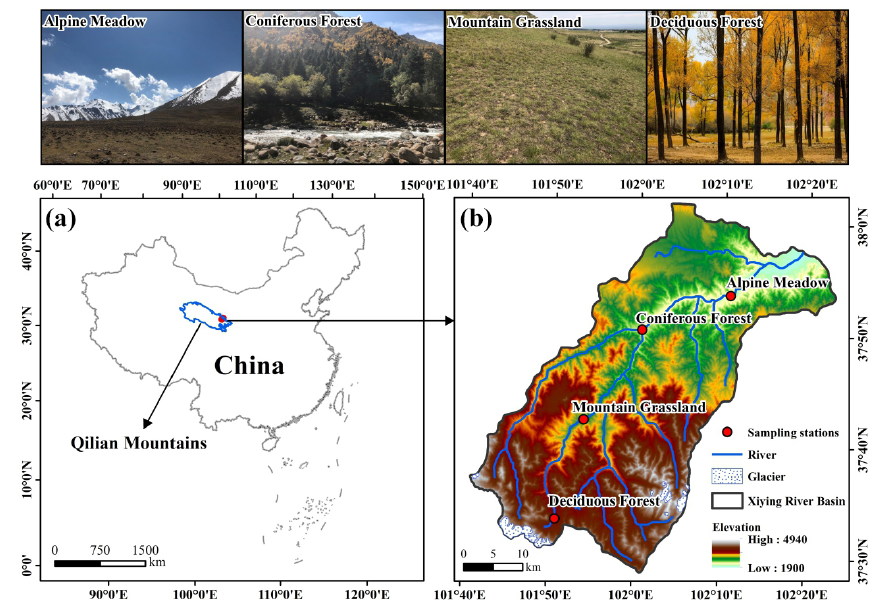
Figure 1. Study area and location of sampling points. (a) The location of the Xiying River basin in China. (b) The terrain and sampling points of the Xiying River